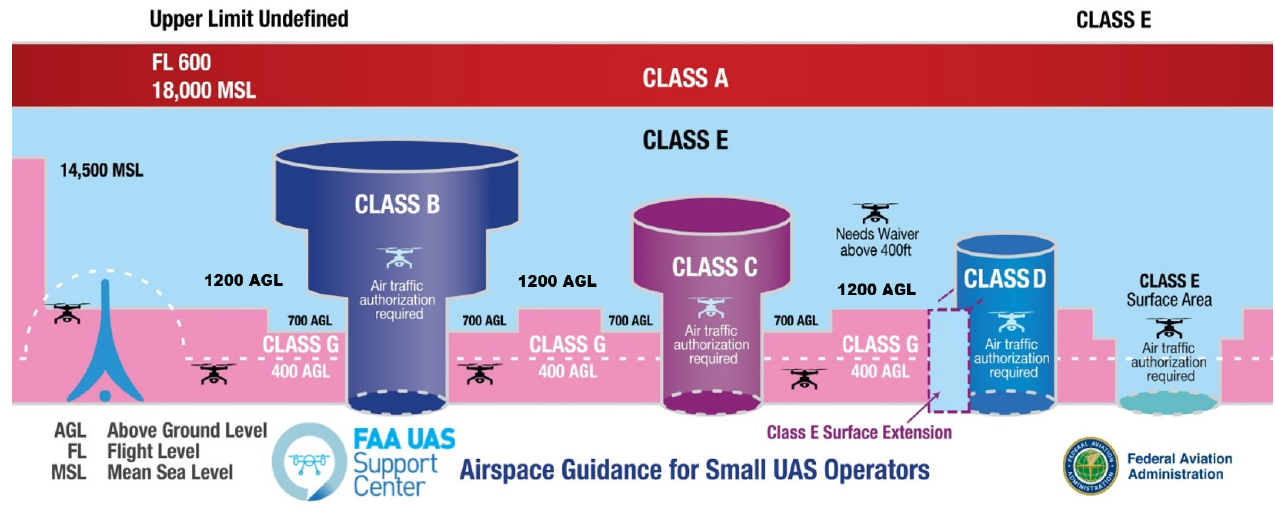
Figure 12. Controlled (Class A, B, C, D, E) and uncontrolled (Class G) airspace in the